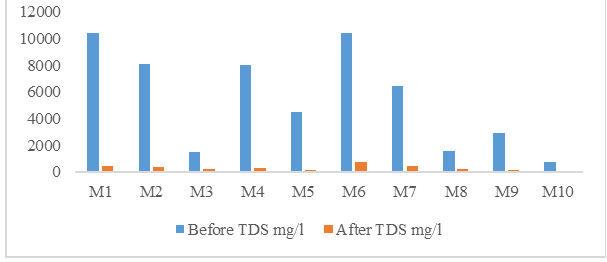
Fig. 3. TDS of Samples before and after Treatment, Mithi City